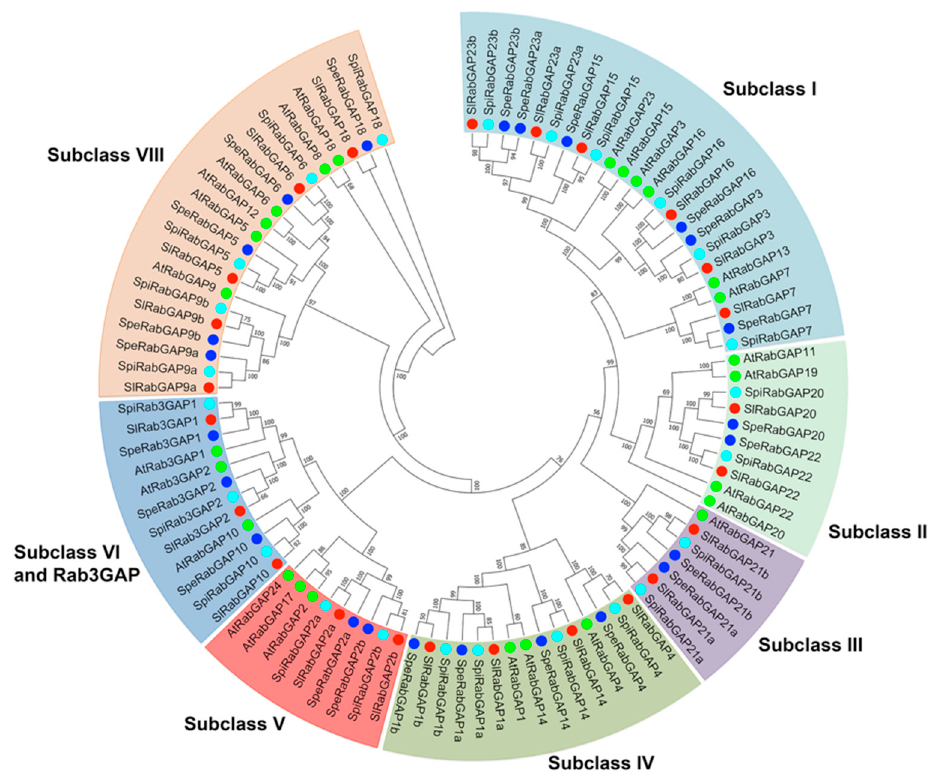
Figure 1. Phylogenetic tree of tomato RabGAPs. Seven subclasses (I, II, III, IV, V, VI, and VIII) were identified. 26 RabGAP of A. thaliana [15] are represented in green circles. In red, 24 RabGAP of S. lycopersicum ; in light blue, 24 RabGAP of S. pimpinellifolium ; and in dark blue, 24 RabGAP of S. pennellii .